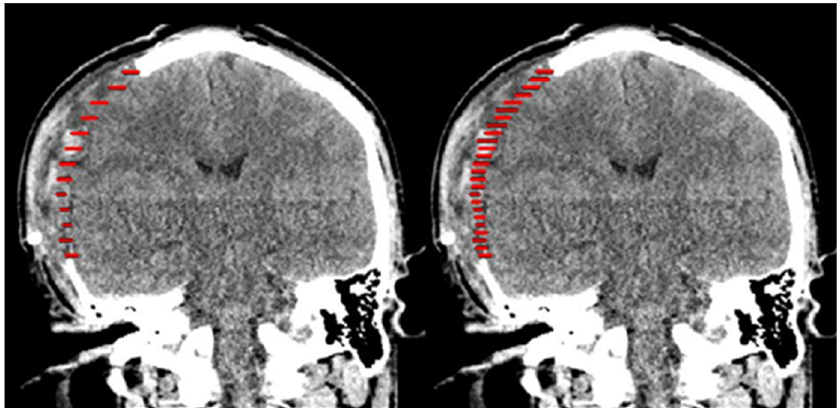
Figure 7. Lines drawn on every tenth axial slice ( left ) and every fifth slice ( right ) on the coronal slice of CT data.